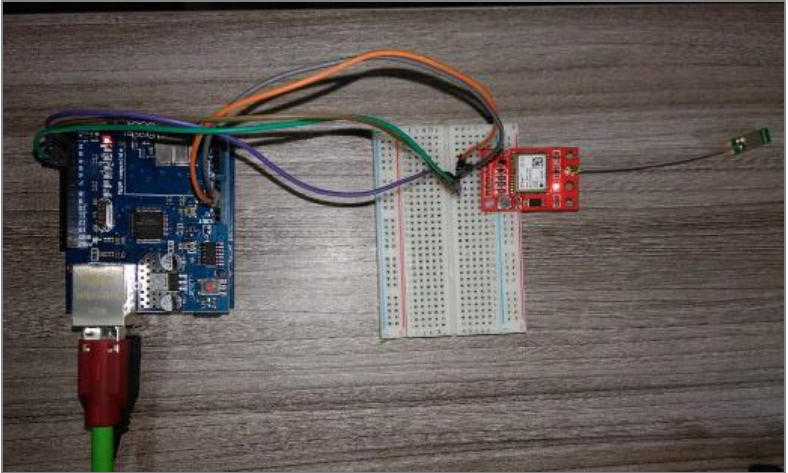
Figure 7. The GPS module, CPU Arduino Uno, and Shield Ethernet.